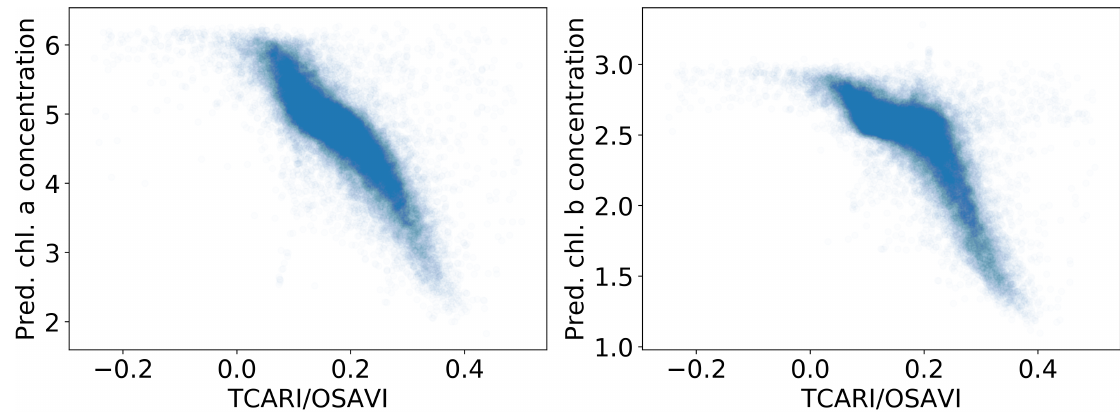
Figure 9. Correlation between chlorophyll and the TCARI